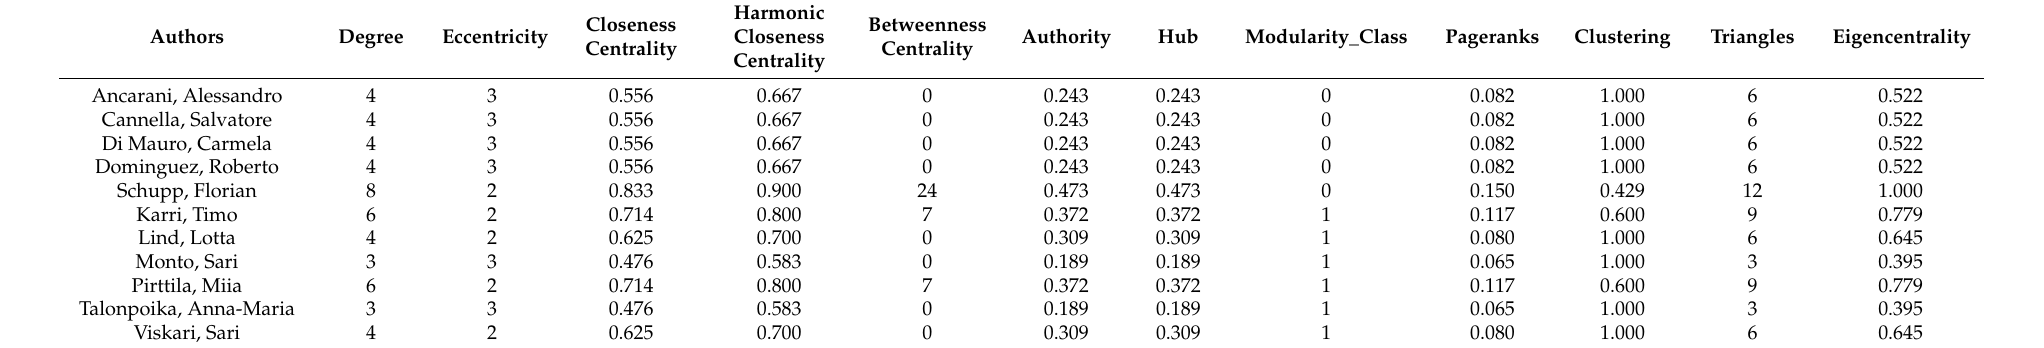
Table 4. Network, node, and edge statistics for co-authorship links and author items, considering 1 as the minimum number of documents of an author.